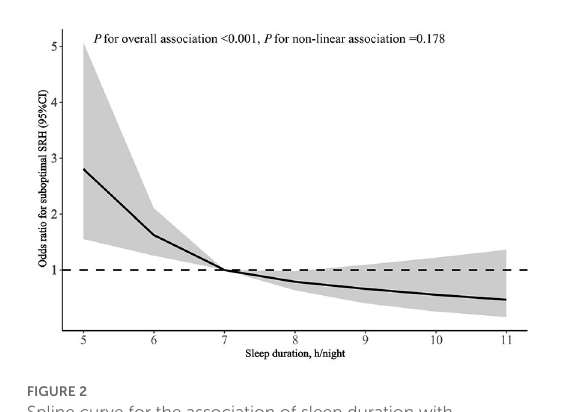
FIGURE2 Spline curve for the association of sleep duration with suboptimal SRH among medical students. Adjusted for sex, grade (sophomore and below, Junior year and above), major (clinical medicine, others), parental education level (elementary school or below, junior middle school, senior high school, university or above), residential district (city, town, village), body type (underweight/normal, overweight/obese), sedentary behavior ( < 9, ≥ 9h), physical activity ( < 2, ≥ 2h), snacking after dinner (yes, no), chronotype (morning type, neutral type, evening type), daytime napping (0, 1–30, > 30min), sleep